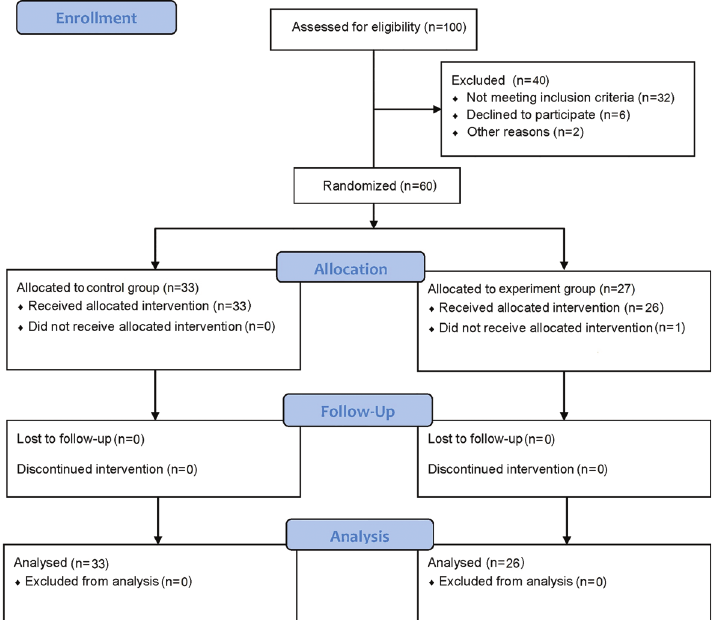
Figure 1. CONSORT diagram describing study fl ow of the participants through enrolment, allocation, follow-up and analysis phases of the trial.